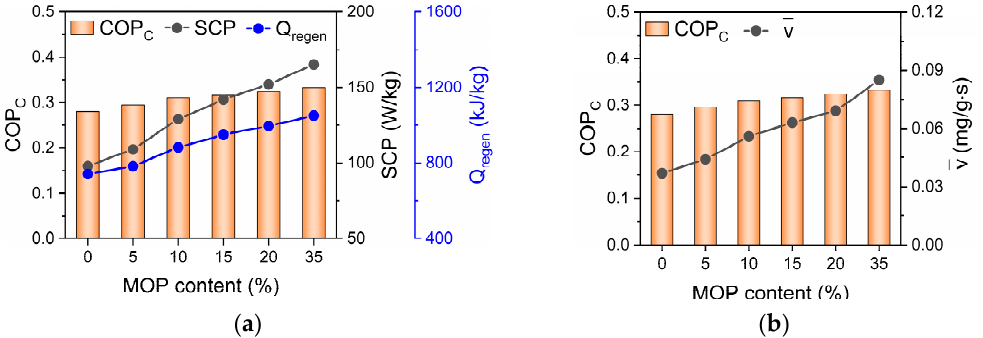
Figure 6. Relationship between ( a ) cyclic working capacity ( Δ q t ), ( b ) water adsorption rate ( v ), and SCP of MOP/MIL-101(Cr)-water working pairs at different MOP 3 content. The COP C is defined as the ratio of the useful energy provided by the device and the required input [43] ⋅ required input [43] SCP t cycle COP = SCP · t cycle C Q COP C = regen Q regen COP C of MOP/MIL-101(Cr)-water increases with MOP 3 content, which exhibited a consistent tendency with total energy consumption of system (Q regen ) and SCP (Figure 7a) as well as water adsorption rate of MOP/MIL-101(Cr) (Figure 7b). The above analysis sug- gests that fast water adsorption of MOP/MIL-101(Cr) can promote SCP. Subsequently, we further investigated the total energy consumption (Q regen ) of MOP/MIL-101(Cr).